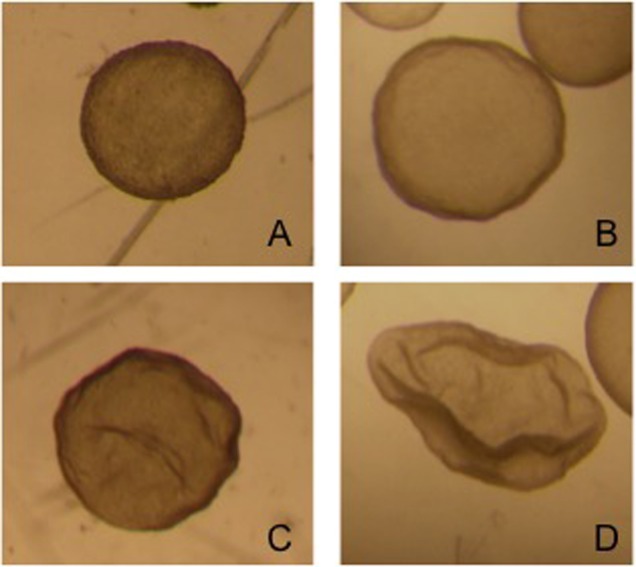
Four different grade 1 llama embryos: (A) spherical and symmetrical embryo, (B) spherical embryo with a slightly irregular contour, (C,D) collapsed embryos, starting the elongation process.